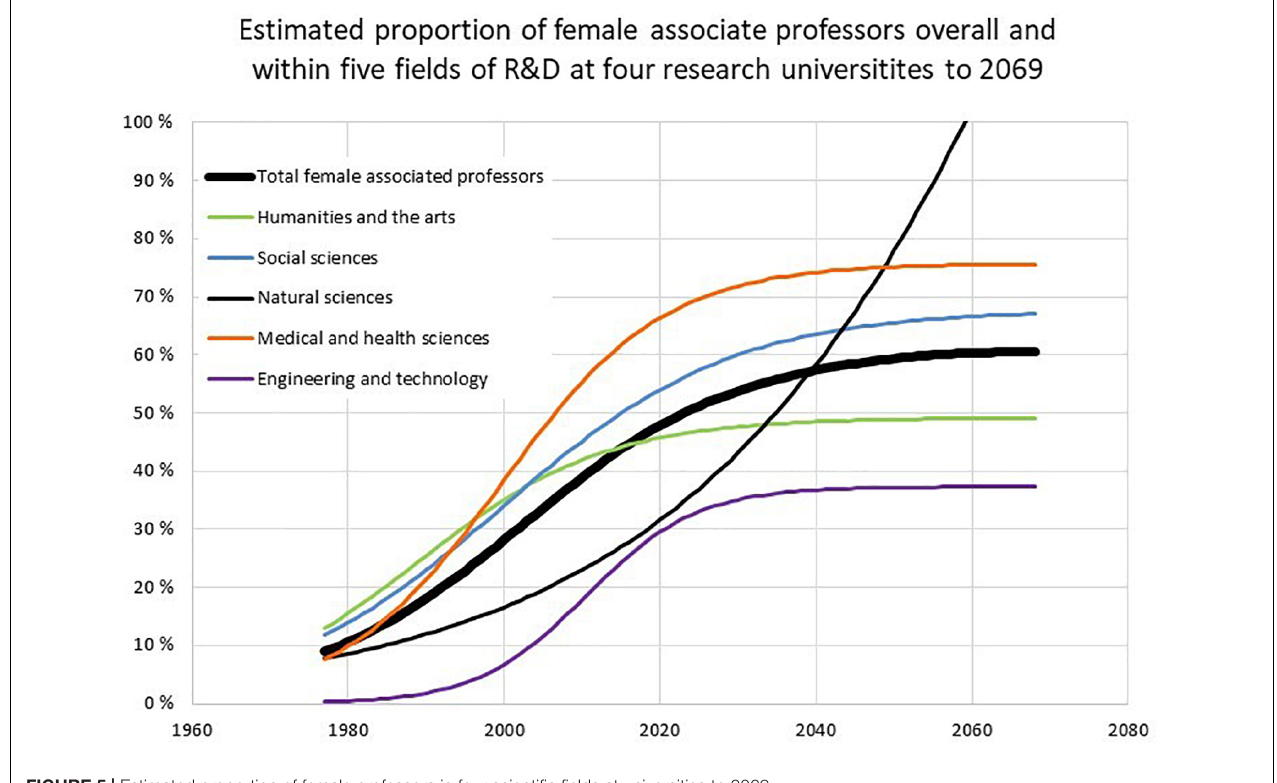
FIGURE 5 | Estimated proportion of female professors in four scientific fields at universities to 2069.